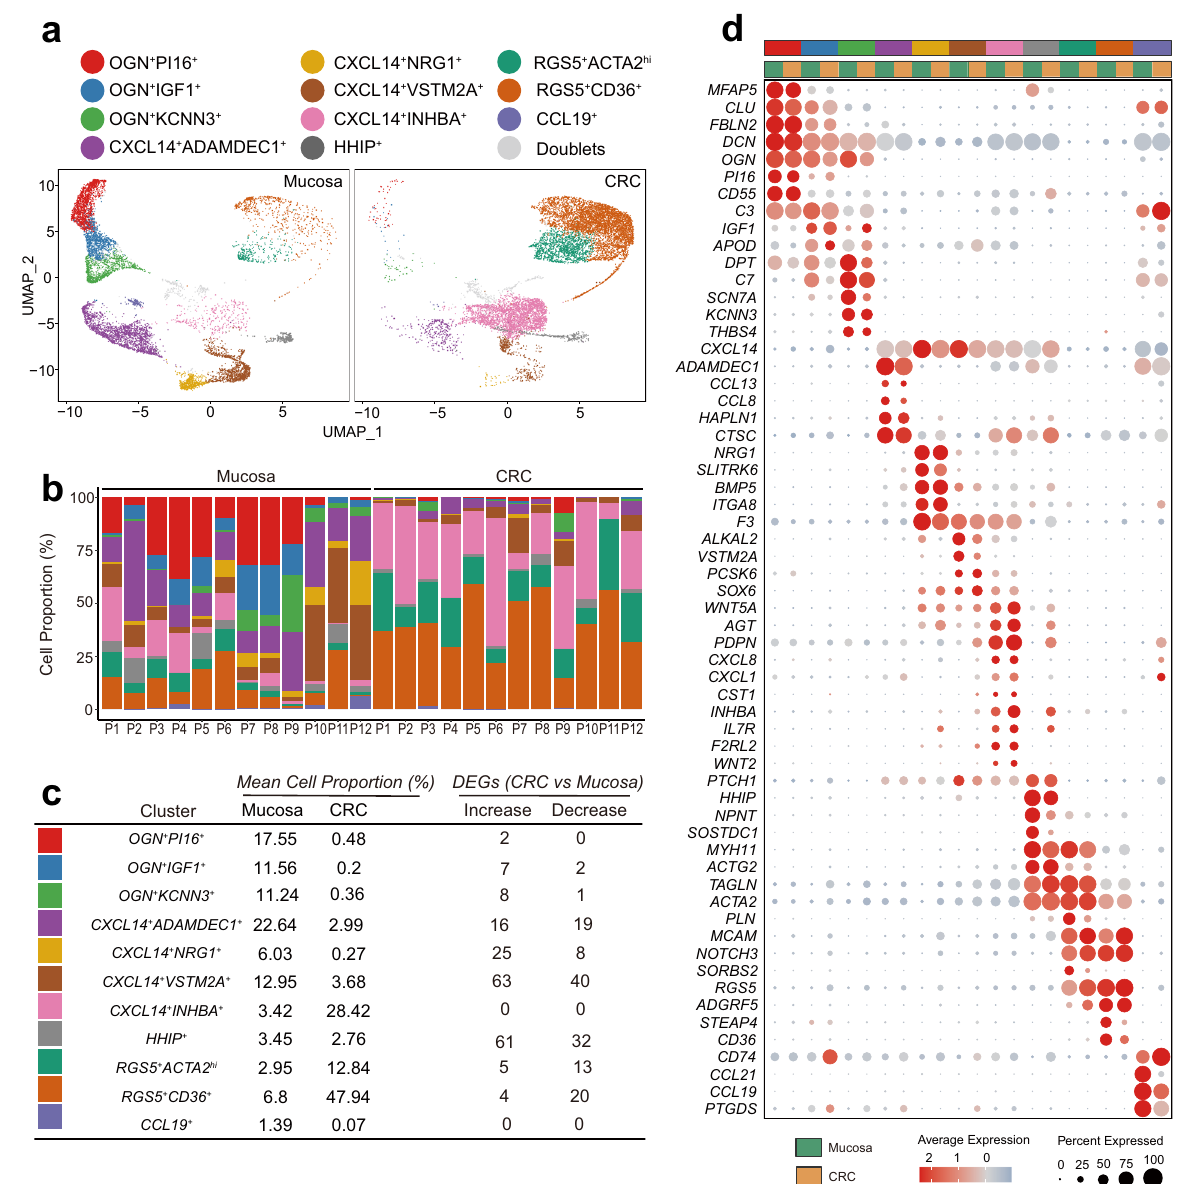
Fig. 4 Integrated analysis of fi broblasts and myo fi broblasts in human colonic mucosa and in human colon cancer tissues. a Comparison of colonic mucosal fi broblasts and colon cancer fi broblasts. UMAP projection of integrated analysis displayed separately by sample type. b Comparison of cell composition between mucosa and cancer tissues in each patient. c Table displays comparison of mean cell proportion of each cluster between mucosa and cancer tissue and number of signi fi cantly differentially expressed genes (padj < 0.05 & Log 2 FC > 1, decrease Increase: padj < 0.05 & Log 2 FC < -1). d Dot plot showing the scaled expression of signature genes for each cluster in mucosa and CRC. The colors representing each cluster in the color band correspond to those in Fig.